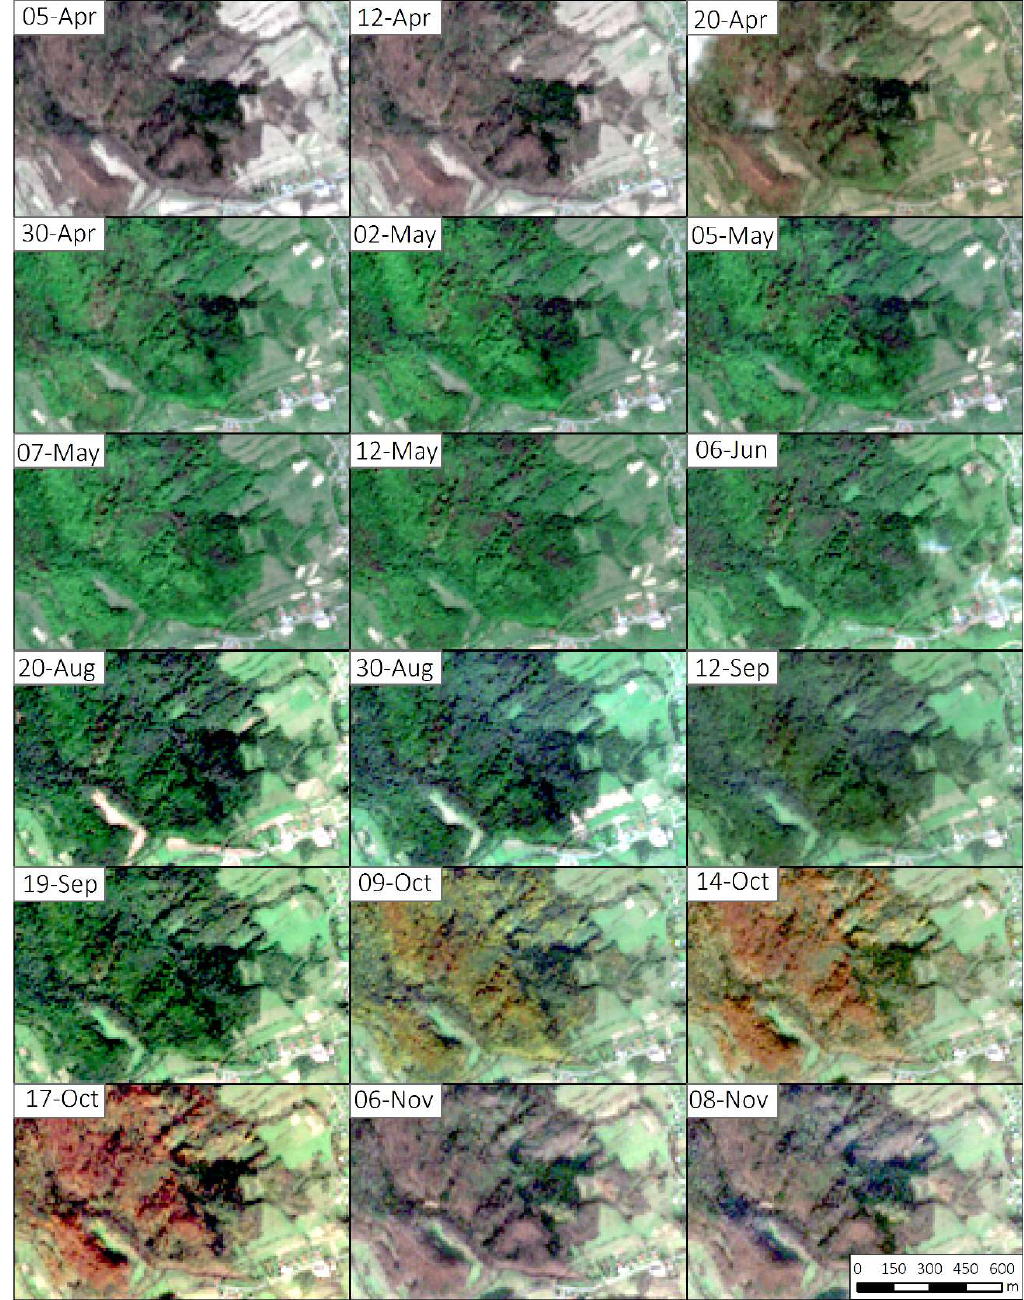
Figure 2. Acquisition dates of Sentinel-2 time-series used in the study with the examples of studied forests.